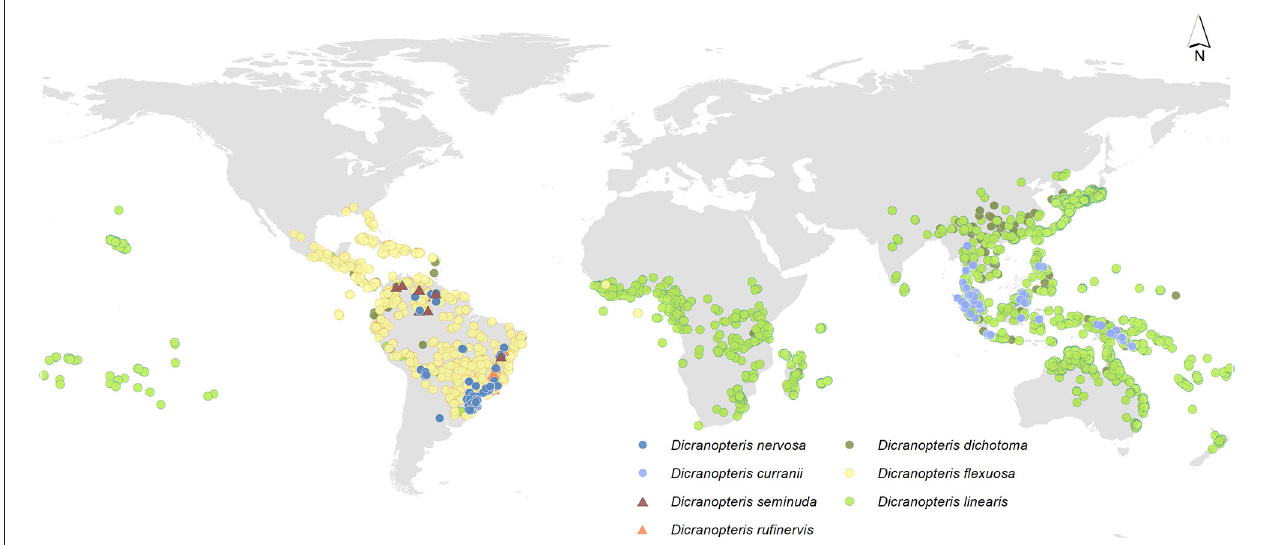
FIGURE 1 | Global distribution of Dicranopteris species, including Dicranopteris dichotoma (deep green dots), Dicranopteris curranii (shallow blue dots), Dicranopteris flexuosa (yellow dots), Dicranopteris seminuda (brown triangles), Dicranopteris nervosa (navy blue dots), Dicranopteris rufiervis (orange triangles), and Dicranopteris linearis (green dots). The distribution information was mainly obtained from Global Biodiversity Information Facility (gbif.org), sampling by Long Yang in East Asia and Lucas Vieira Lima in the